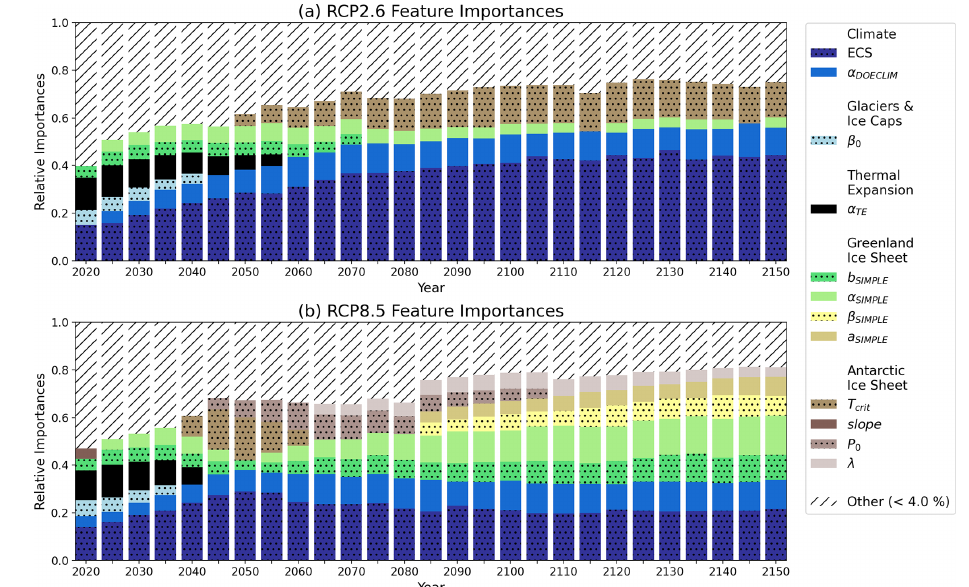
Figure 2. Relative feature importances of the BRICK model parameters calculated based on the fitted random forests. Shown are the importances of the BRICK model parameters using (a) the RCP2.6 radiative forcing scenario and (b) the RCP8.5 forcing scenario. All model parameters with an importance less than 4% were grouped into an “other” category, which is shown with hatch marks to denote its difference from the parameters. Stippling was added to alternating parameters in the legend to aid in telling the difference between similar colors. An “other” threshold of 4% was chosen because uniform importance across the parameters is 2.6% importance for each parameter. Using a threshold close to 2.6% would show parameters that were not substantially different than the average